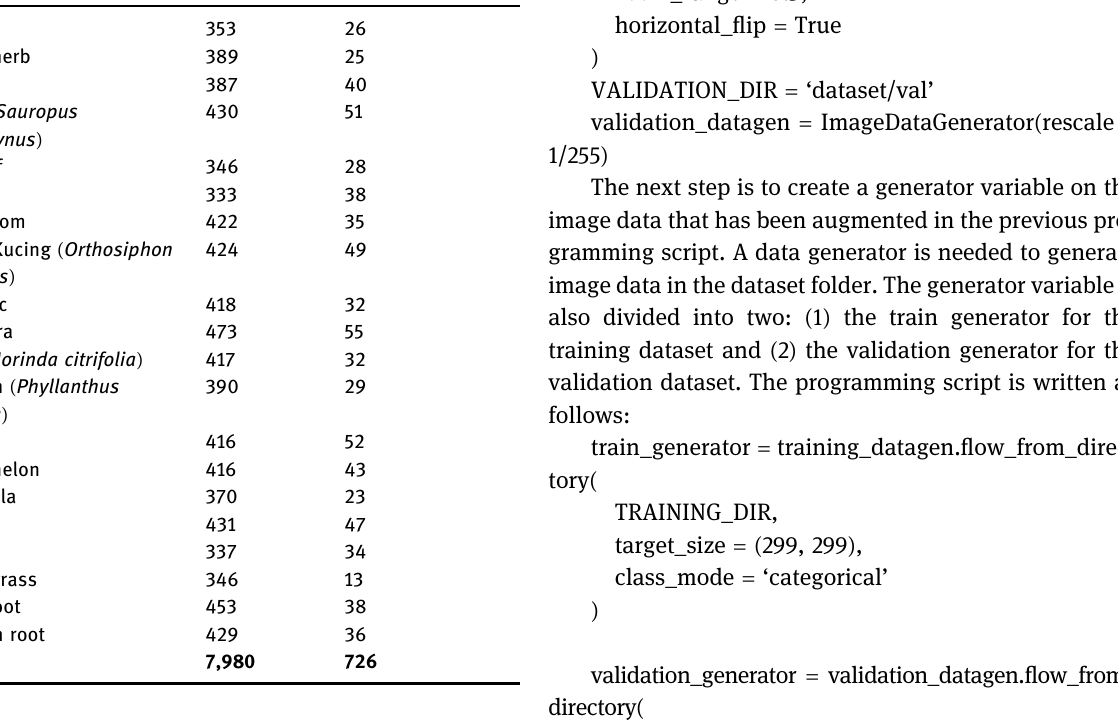
Table 1: Number of train and validation datasets for each herb type Herb type ( class ) Train Validation dataset